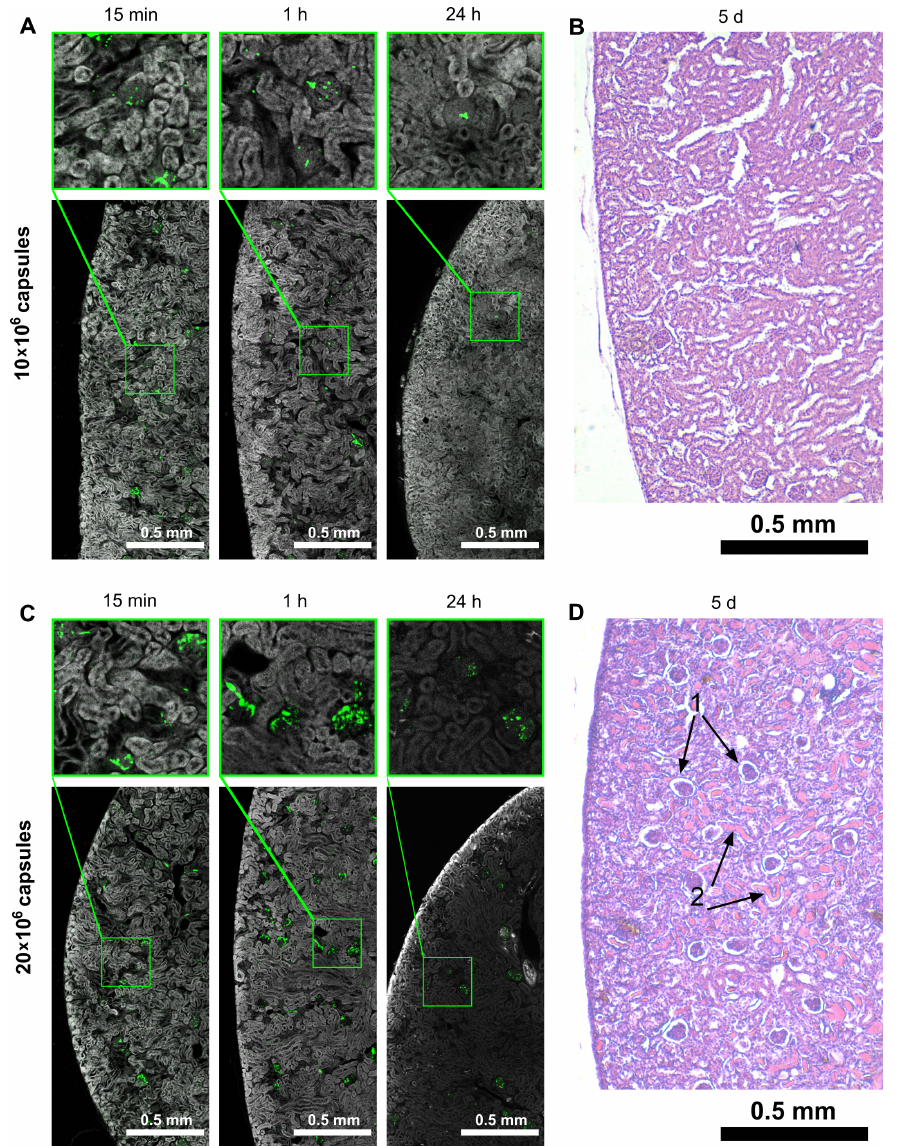
Figure 4. Distribution of capsules administered to the left kidney and dose-dependent impact on the kidney’s structure. Fluorescent microscopy of the target kidney’s cryosections 15 min, 1, and 24 h after microcapsules’ injection at a dose of 10 × 10 6 ( A ). Histological section of the target kidney 5 days after 10 × 10 6 capsules’ administration (H & E staining) ( B ). Fluorescent microscopy of the target kidney’s cryosections 15 min, 1, and 24 h after microcapsules’ injection at a dose of 20 × 10 6 ( C ). Histological section of the target kidney 5 days after 20 × 10 6 capsules’ administration (H & E staining). 1—Bowman’s capsule is dilated, 2—plasma proteins in the lumen of the tubule ( D